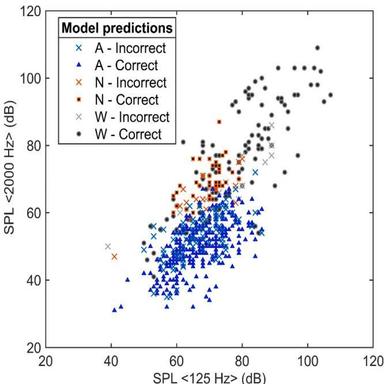
Scatter plot showing the clustering of spectra by zone type, and the capability of the supervised machine learning algorithm to correctly classify the spectra by zone. In this graph a low frequency band (125 Hz) and a medium frequency band (2000 Hz) were selected to show the dispersion of the data.